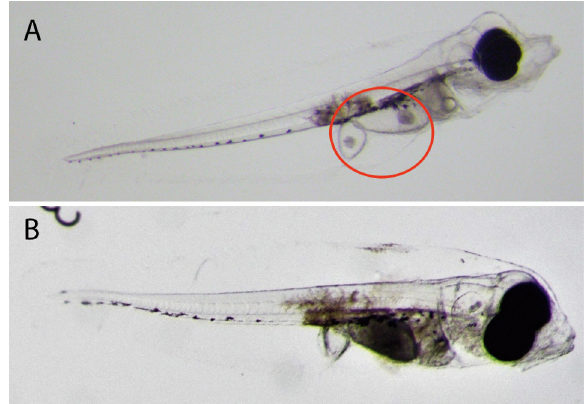
Fig. 9. (A) Saccostrea glomerata trochophores (circled) ob- served swimming in the digestive tract of a 3 day